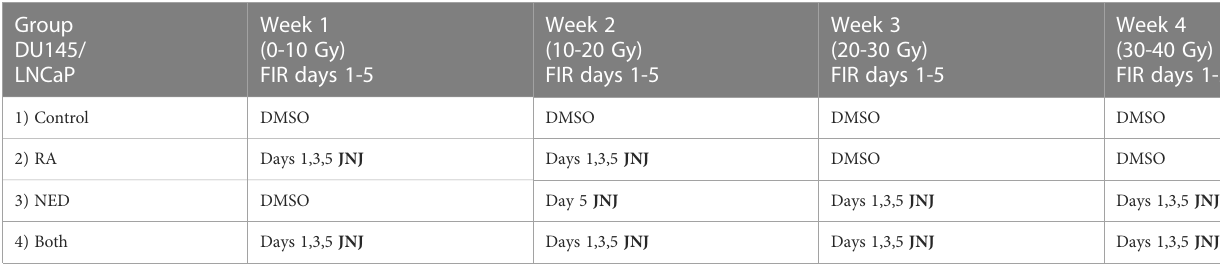
TABLE 1 FIR and JNJ64619178 (JNJ) treatment for targeting NED. Group